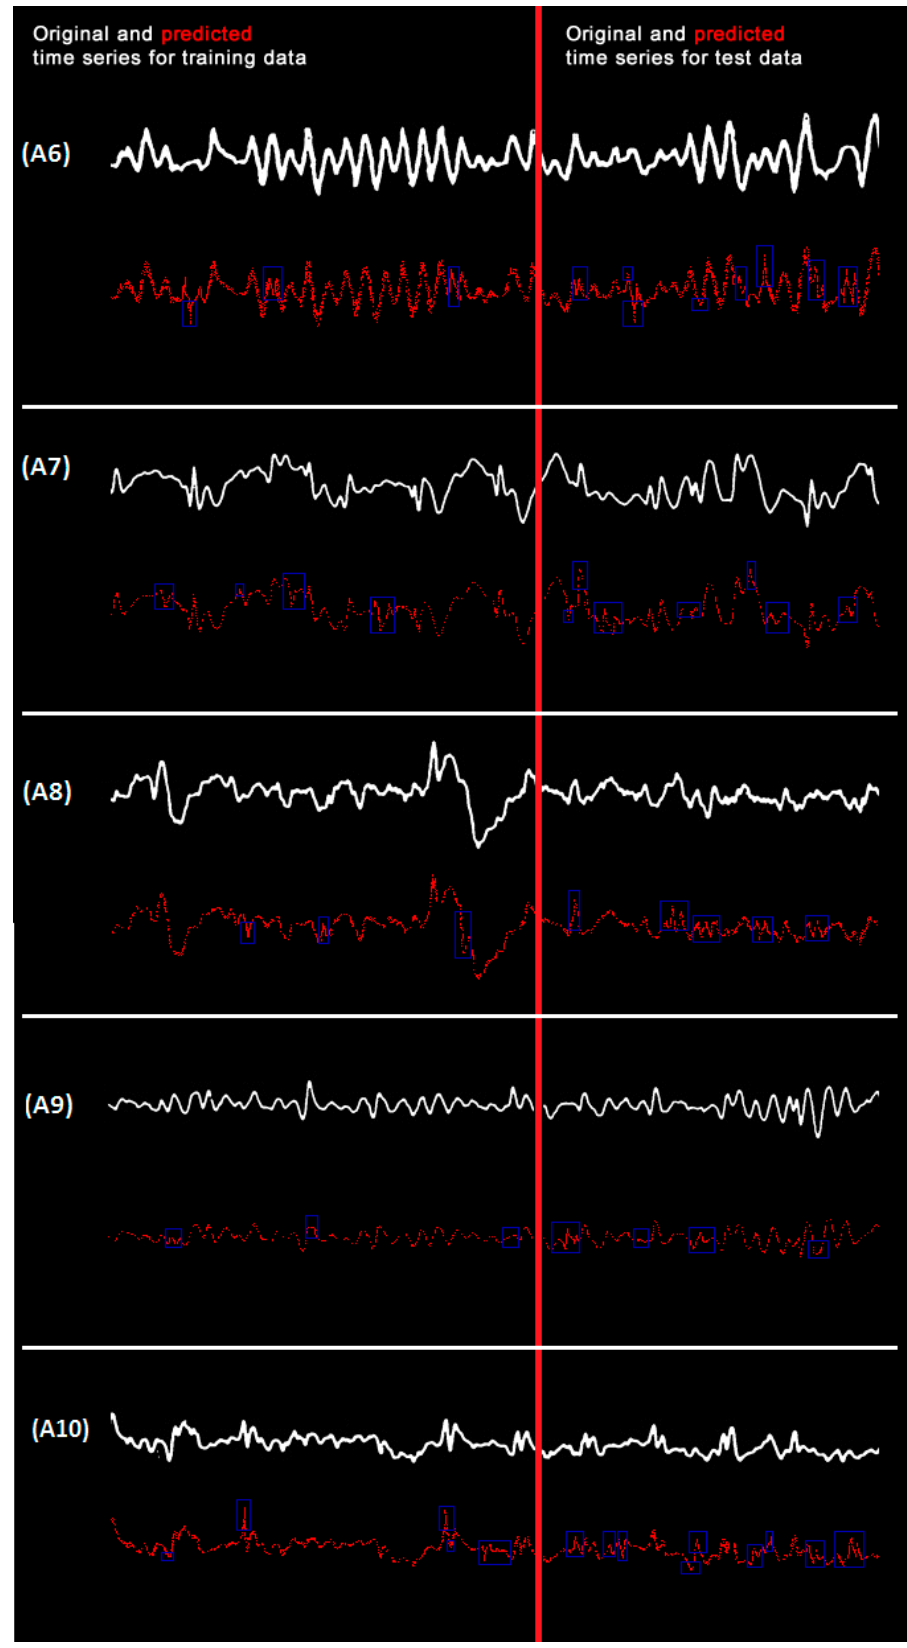
Figure 8. Predictions for both training and test data regarding the EEG time series: A6 – A10 (the white line shows the original data, and the red dots are for predictions. Some visible and remarkable periods, including errors, are represented by blue squares).